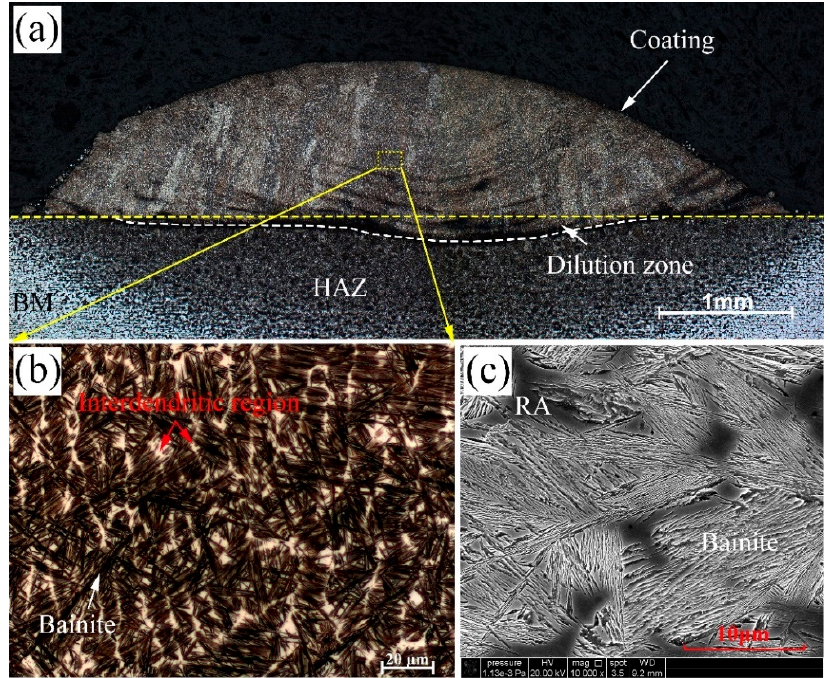
Figure 2. The profile of the laser cladded coating ( a ), and detailed images of the isothermal microstructures in the center region observed by OM ( b ) and SEM ( c ).